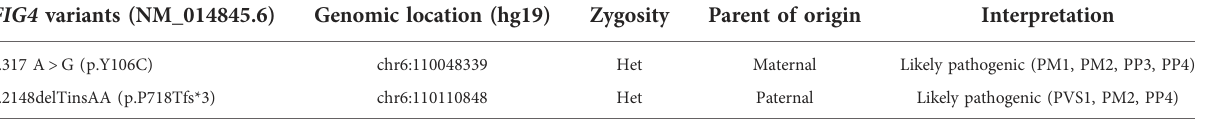
TABLE 1 Genomic fi ndings and variants interpretation.